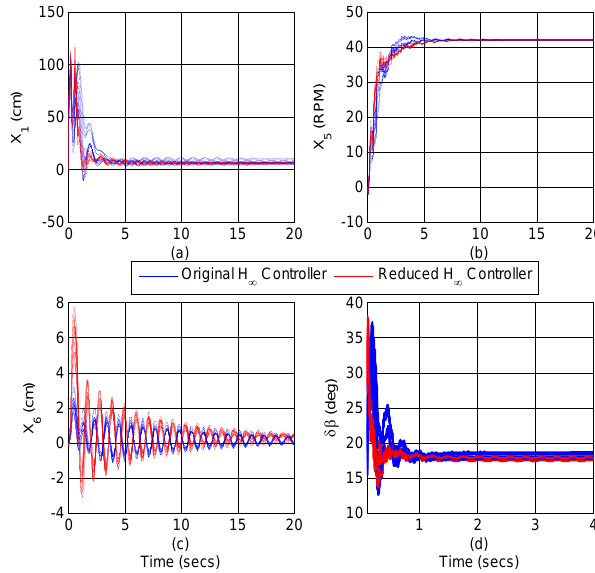
Figure 11. Transient responses of state variables (a- c) and controlled blade pitch angle (d) of wind